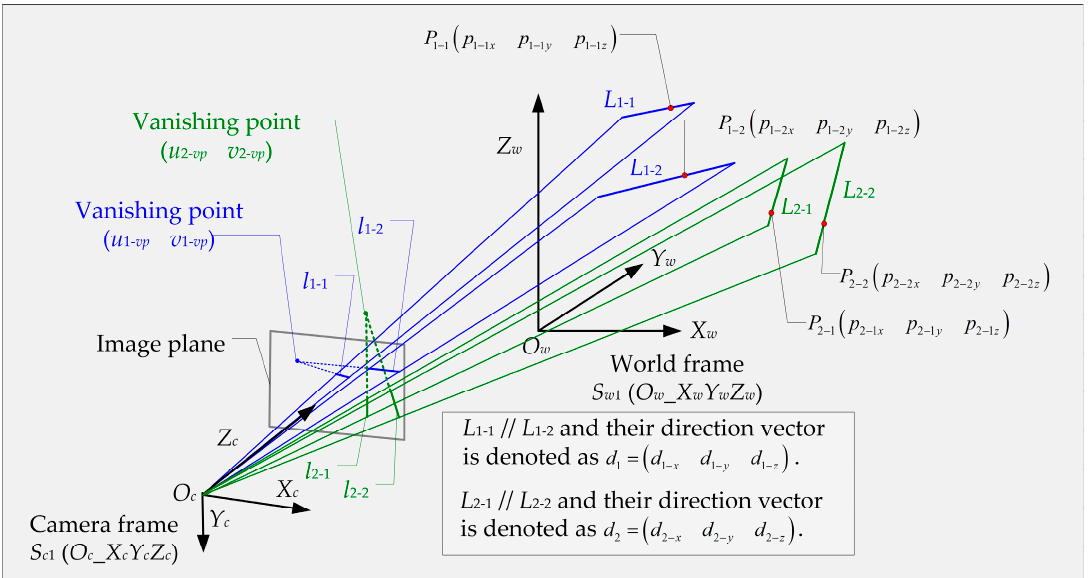
Figure 1. The geometric construction of this paper includes two sets of parallel lines (blue and green), the corresponding projections and vanishing points on the image plane.